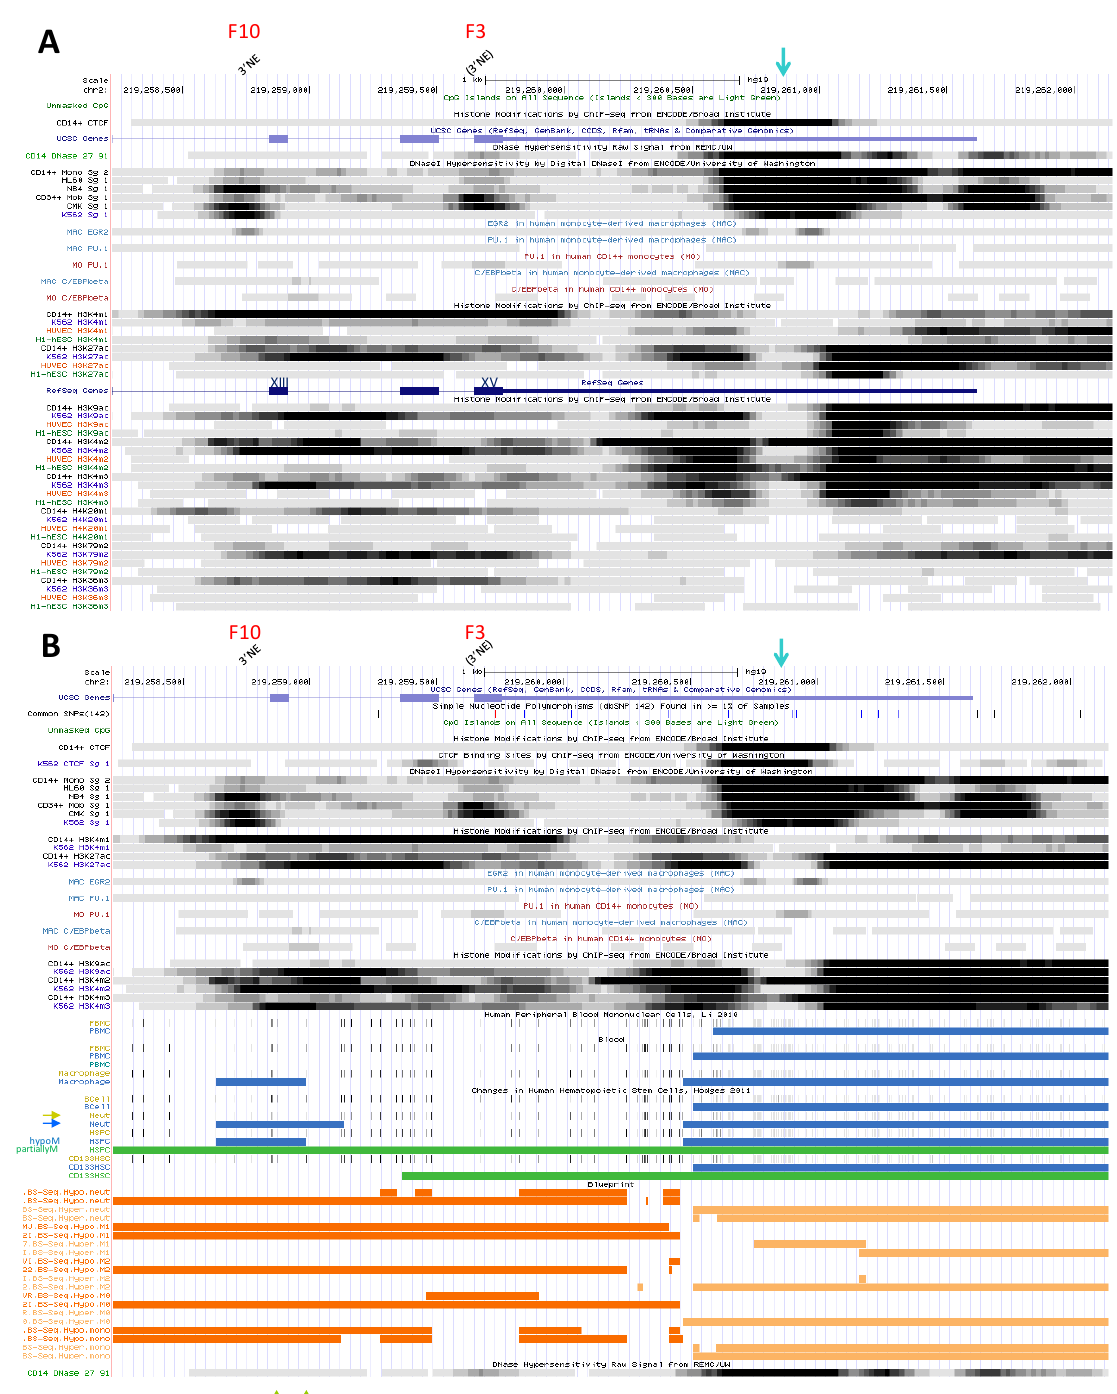
Figure 6. Epigenetic modifications at NRAMP1 locus region v, encompassing Dnase1 footprints F10 and F3 (described in text Sections 2.3.1.6 and 2.3.1.7). ( A ), ( B ) same as Figure 2.